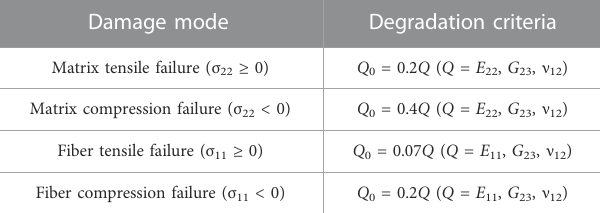
TABLE 3 Material stiffness degradation criterion.